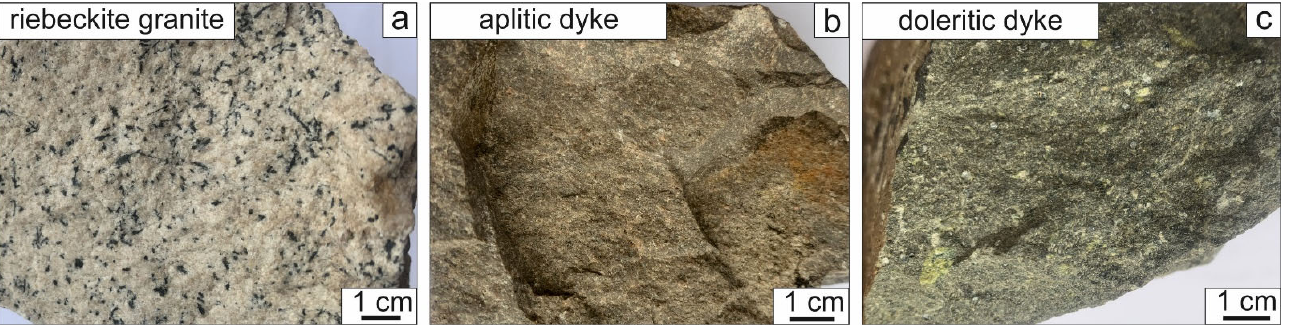
Figure 3. Photographs of ( a ) riebeckite granite sample, ( b ) aplitic dyke sample, and ( c ) doleritic dyke sample from the Tannuola terrane.